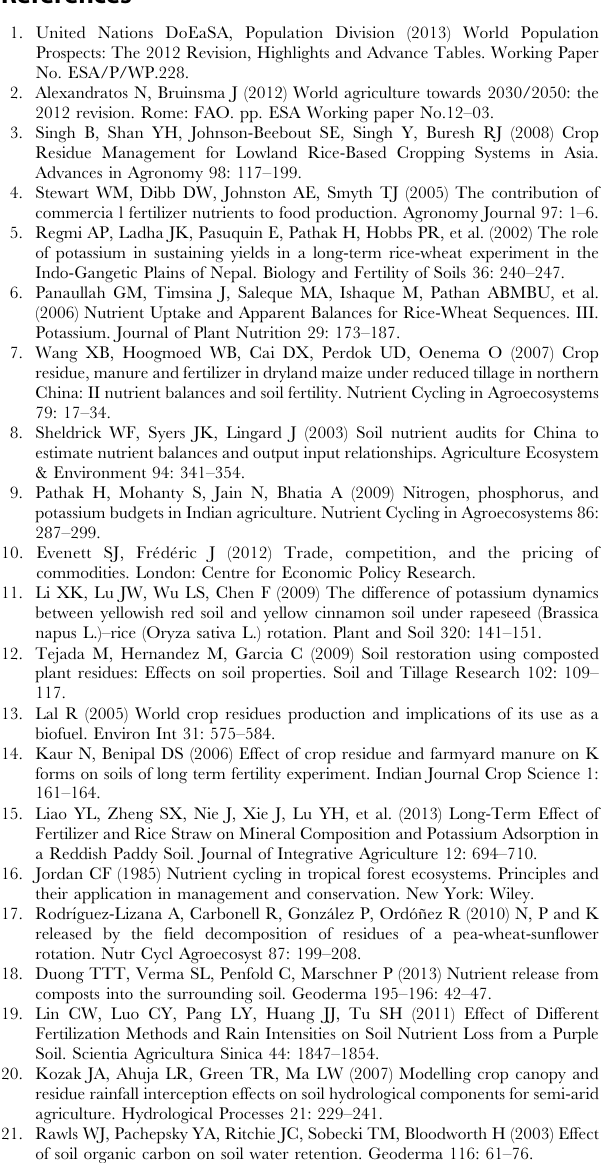
Figure S1 Schematic diagram of the experimental setup of the straw decomposition trial. The depth of the bulk soil in boxes was approximately 22 cm, and that of the flooding layer was 1 cm. The nylon bags were buried into the soil according to the orientation in the diagram. Figure S2 The adsorption of potassium (K) on wheat and rape straws for different decomposition